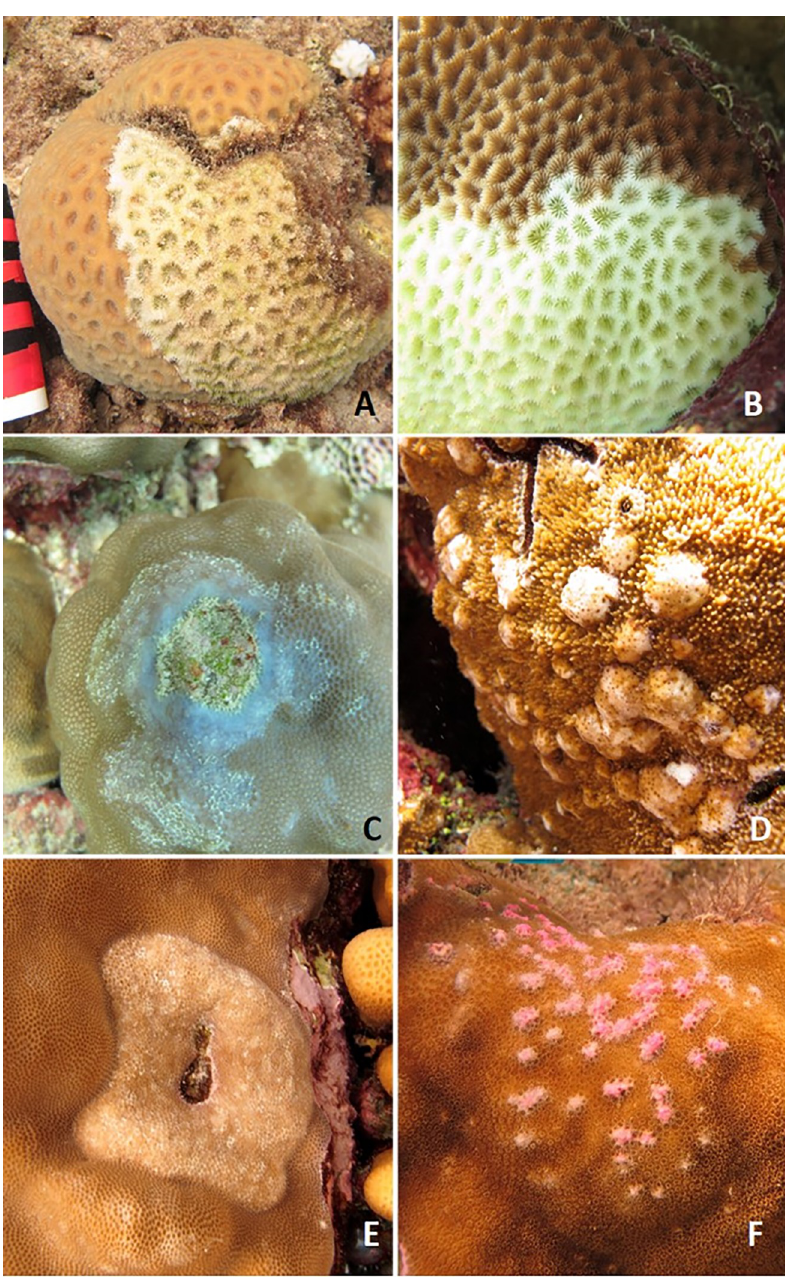
Fig 5. Representative types of lesions sampled for histopathology. A) Acute tissue loss ( > 5cm bare, white skeleton), Dipsastraea sp., B) Acute tissue loss ( > 5cm bare, white skeleton), Goniastrea sp., C) Chronic tissue loss ( < 1cm bare, white skeleton) with discoloration, Porites sp., D) Growth anomaly, Montipora sp., E) Growth anomaly, Porites sp., F) Multifocal pink discoloration with tissue swelling, Porites